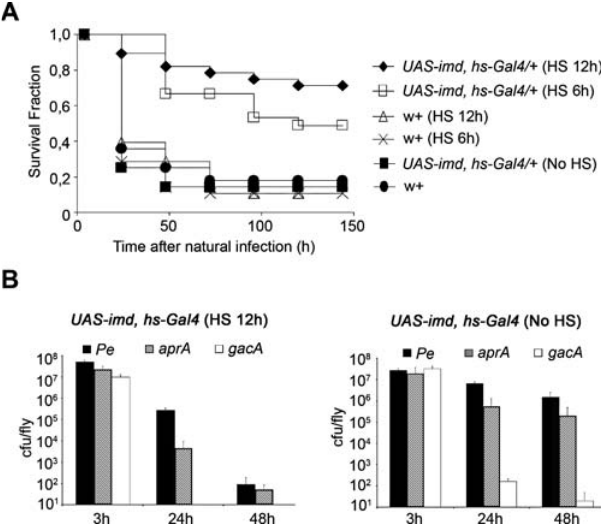
Figure 4. AprA Confers Protection against the Imd-Dependent Immune Response (A) Over-expression of the Imd immune pathway protects against P. entomophila infection during gut infection. The genotypes of the flies are as indicated. Over-expression of the UAS-imd construct with an hs-GAL4 driver induces strong expression of the Diptericin gene in the absence of infection [39]. The expression was triggered once (1 h heat-shock at 37 8 C) 6 h and 12 h prior to infection. The percentage of surviving flies ( n ¼ 60) after infection with wild-type P. entomophila is shown. This experiment was repeated three times and gave similar results. Log-rank analysis demonstrated a statistically significant difference in survival of wild-type flies and UAS-imd, hs-Gal4/ þ (HS 12 h) flies fed with wild-type P. entomophila ( p , 0.0001). HS, heat-shock. (B) Persistence of aprA, gacA, and wild-type P. entomophila in adults over- expressing imd 12 h prior to infection. AprA bacterial titers decrease faster with time than the ones of wild-type bacteria. The gacA mutant fails to survive in the intestine of flies over-expressing imd . The number of cfus per fly represented in each histogram corresponds to the average of six independent experiments ( 6 standard deviation). cfu, colony- forming